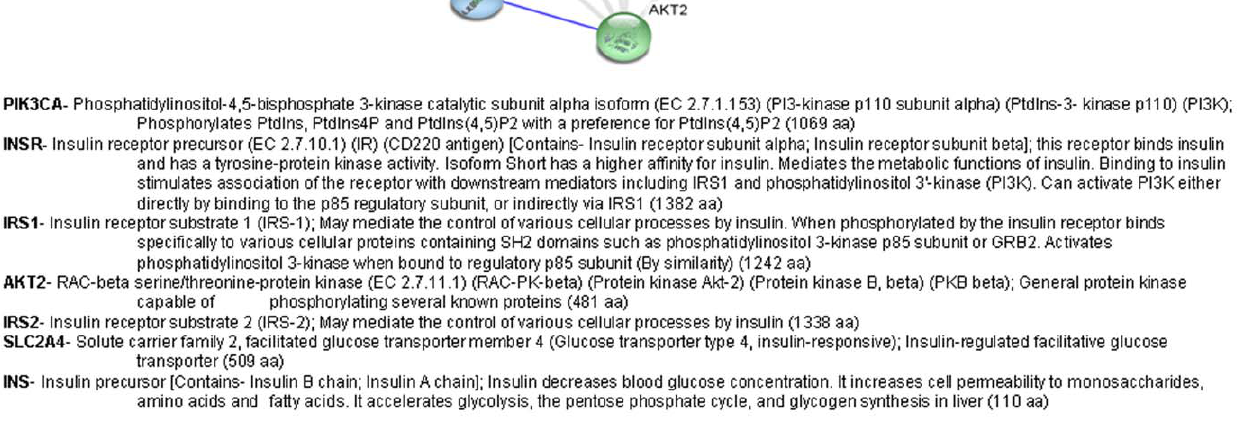
Figure 7. Protein-protein network in insulin signal transduction pathway.